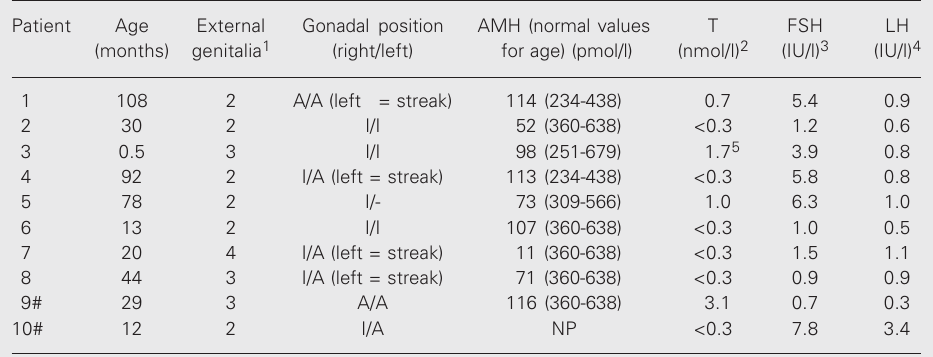
Table 1. Genital phenotype and hormonal data of 10 children with 46,XY partial gonadal dysgenesis who participated in the study.